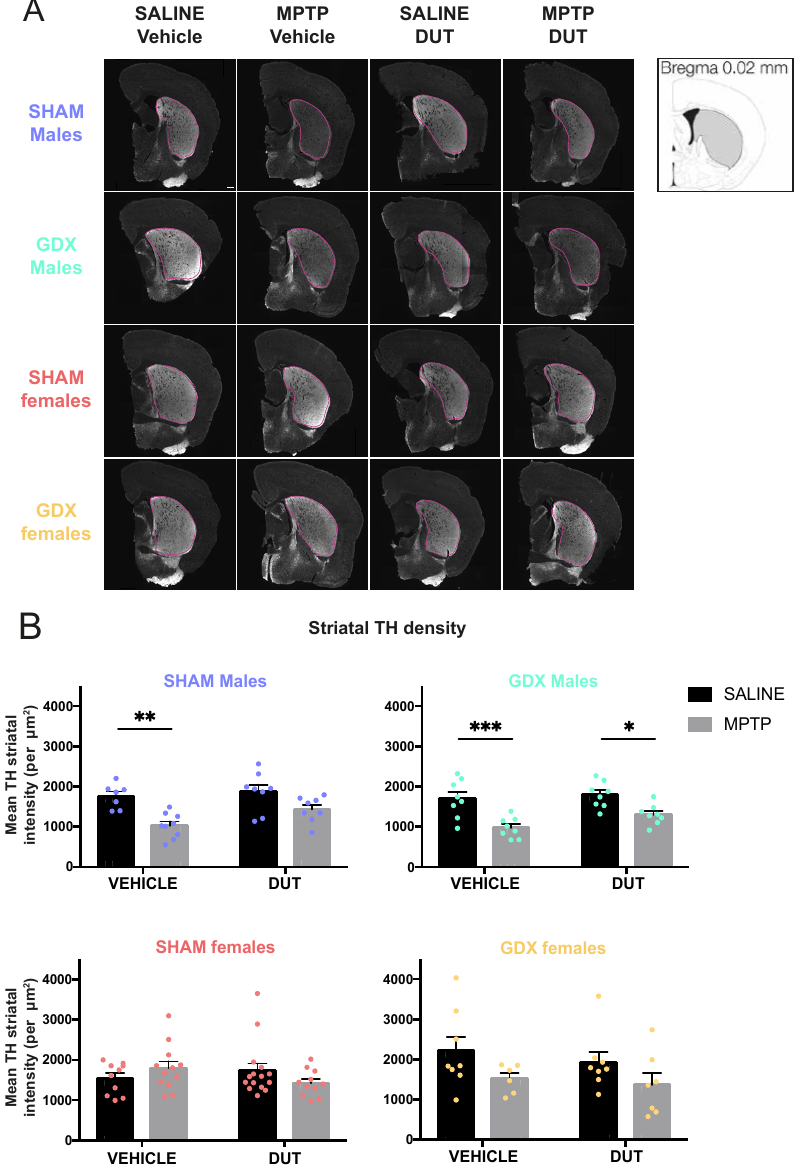
Figure 1. Effect of mice gonadal status (SHAM, GDX), MPTP, and dutasteride (DUT) treatment on TH striatal levels. ( A ) Representative example of striatal TH immunofluorescence. Scale bar = 1000 µ m and ( B ) TH striatal intensity in SHAM and GDX males and SHAM and GDX female mice. Values shown are the means pixel intensity ± SEM of 6-16 mice per group. Two-way ANOVA, Tukey post-hoc test: * p < 0.05, ** p < 0.01 and *** p < 0.001.